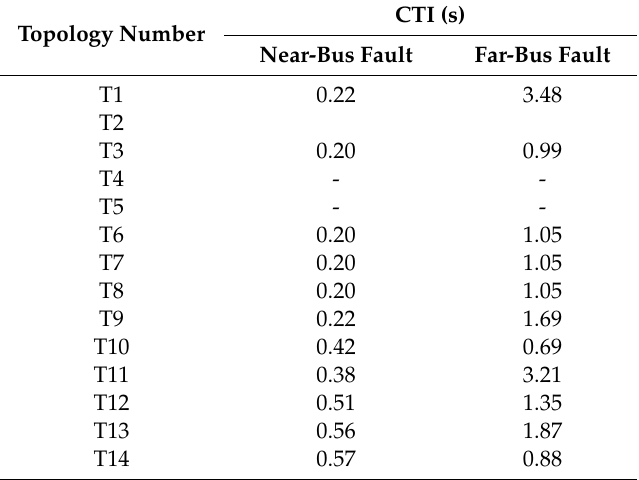
Figure 6. ( a ) Current seen by backup R7 for both near-end and far-end faults; ( b ) R7 backup operating. Table 18. Relay 4 and 7 pair CTI variation for different topologies.